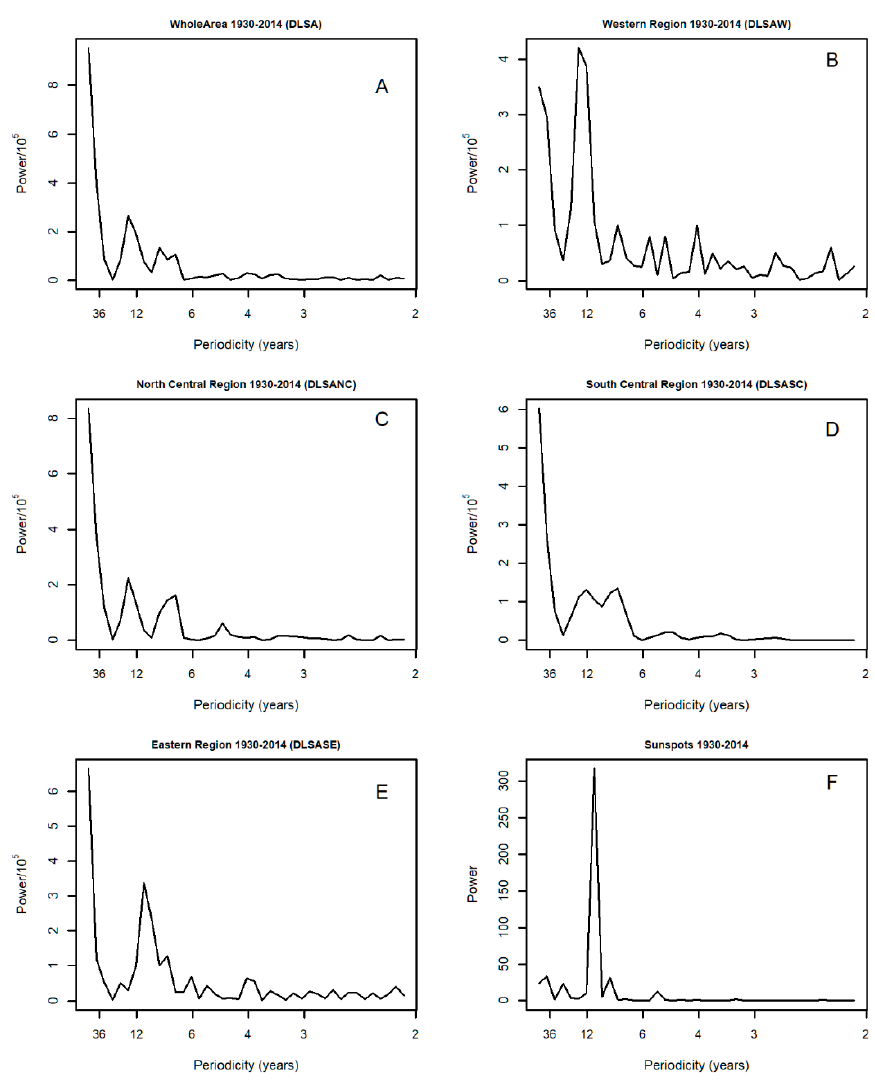
Figure 3. Periodograms of ( A ) 1930–2014 data for the total number of 1° grid squares infested with Desert Locusts (DLSA), ( B – E ) for each of the 4 regions ( B : DLSAW, C : DLSANC, D : DLSASC, E : DLSAE) and ( F ) the sunspot groups.